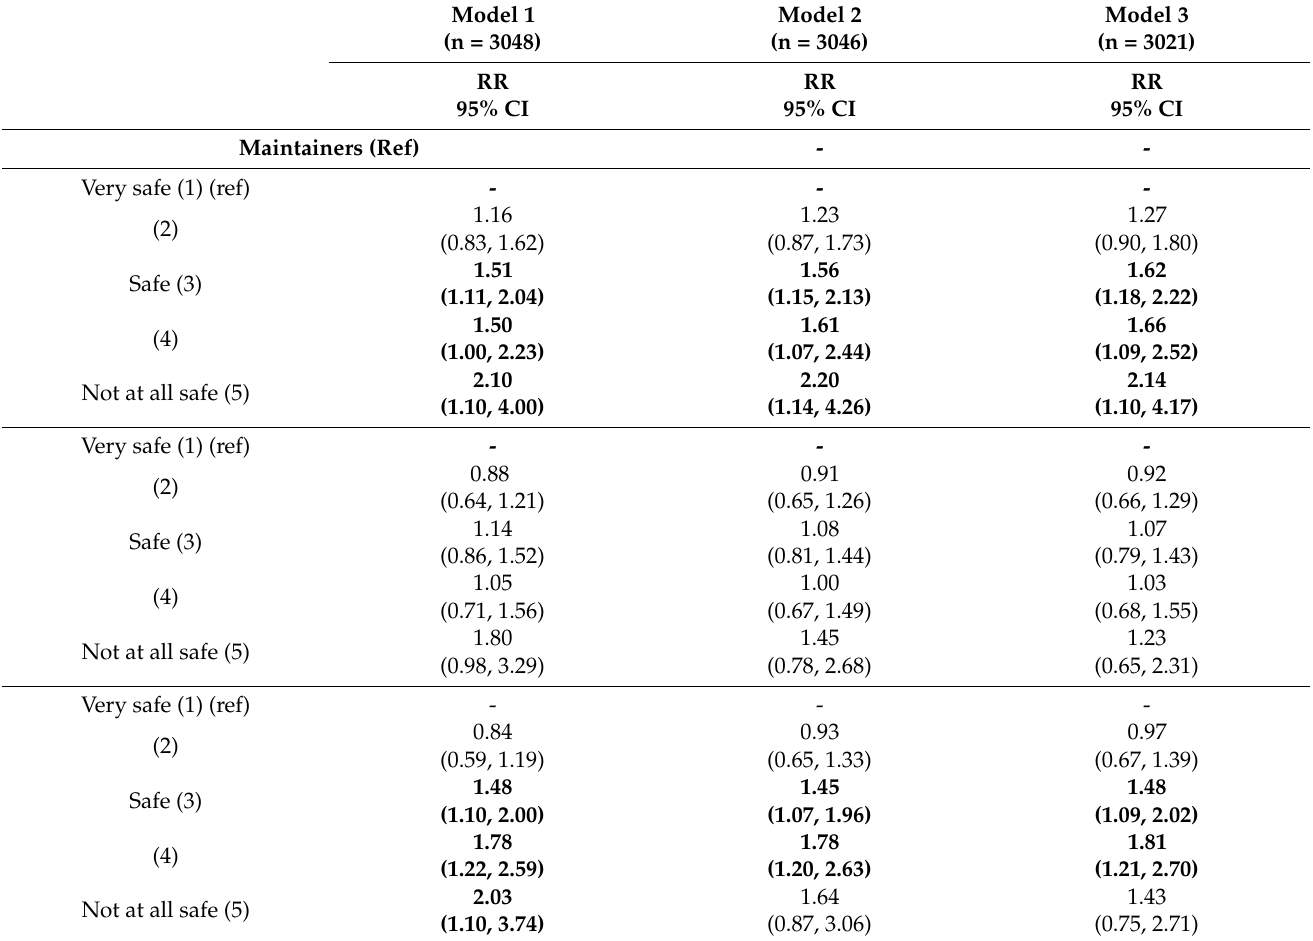
Model 1: adjusted for study site and contextual markers of SES; Model 2: model 1 + age, sex, race/ethnicity, educational level, marital status, and occupation; Model 3: model 2 + waist circumference, LDL cholesterol, HDL cholesterol, triglycerides, hypertension, diabetes, smoking, alcohol, emphysema, asthma, arthritis, pain in the lower limbs and swelling of feet and ankles. CI: confidence interval; RR: risk ratio; PA: physical activity. Significant association shown in bold